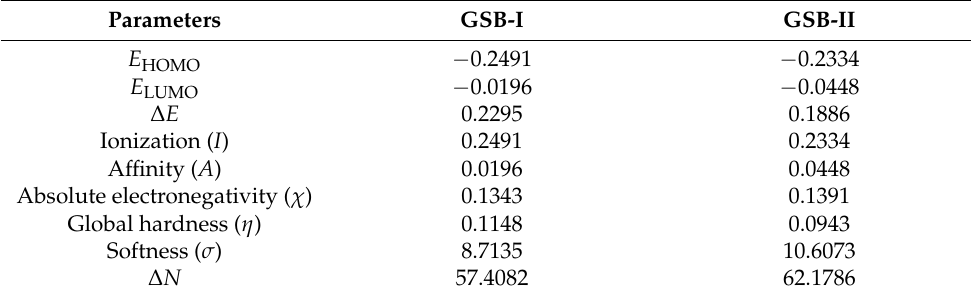
Table 5. The calculated quantum chemical parameters for GSB